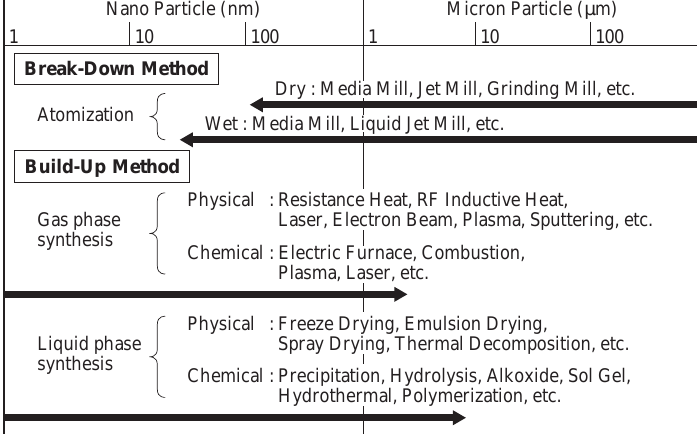
Fig. 1 Production methods for nano particles and micron